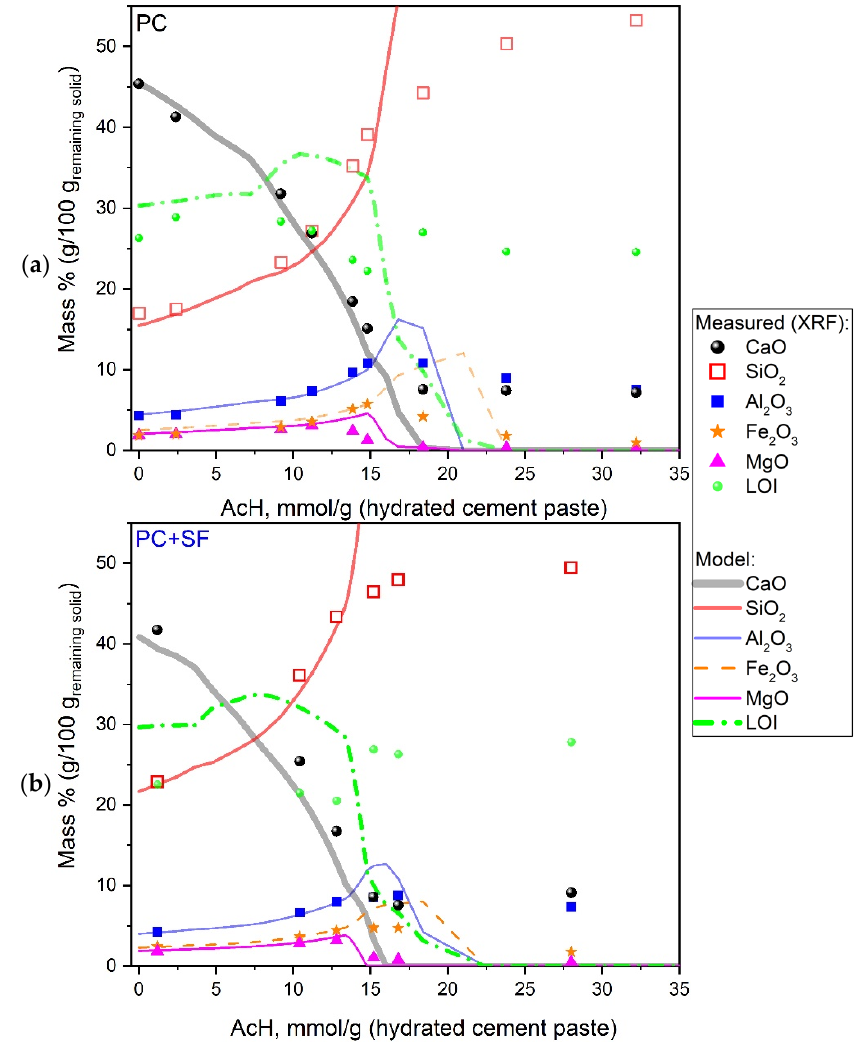
Figure 6. Concentration of undissolved elements in remaining solids as a function of acid concentration: comparison of XRF measurements with model predictions: PC ( a ) and PC + SF samples ( b ).